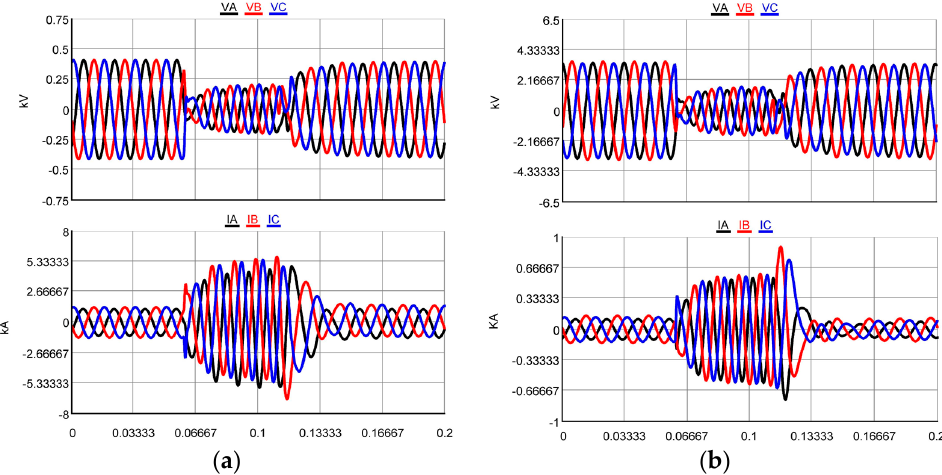
Figure 13. Three-phase fault applied at bus 6 in the transmission system of the testbed: ( a ) instantaneous voltage and current at bus 634 with 750 W/m 2 solar irradiance; ( b ) instantaneous voltage and current at bus 680 with 750 W/m 2 solar